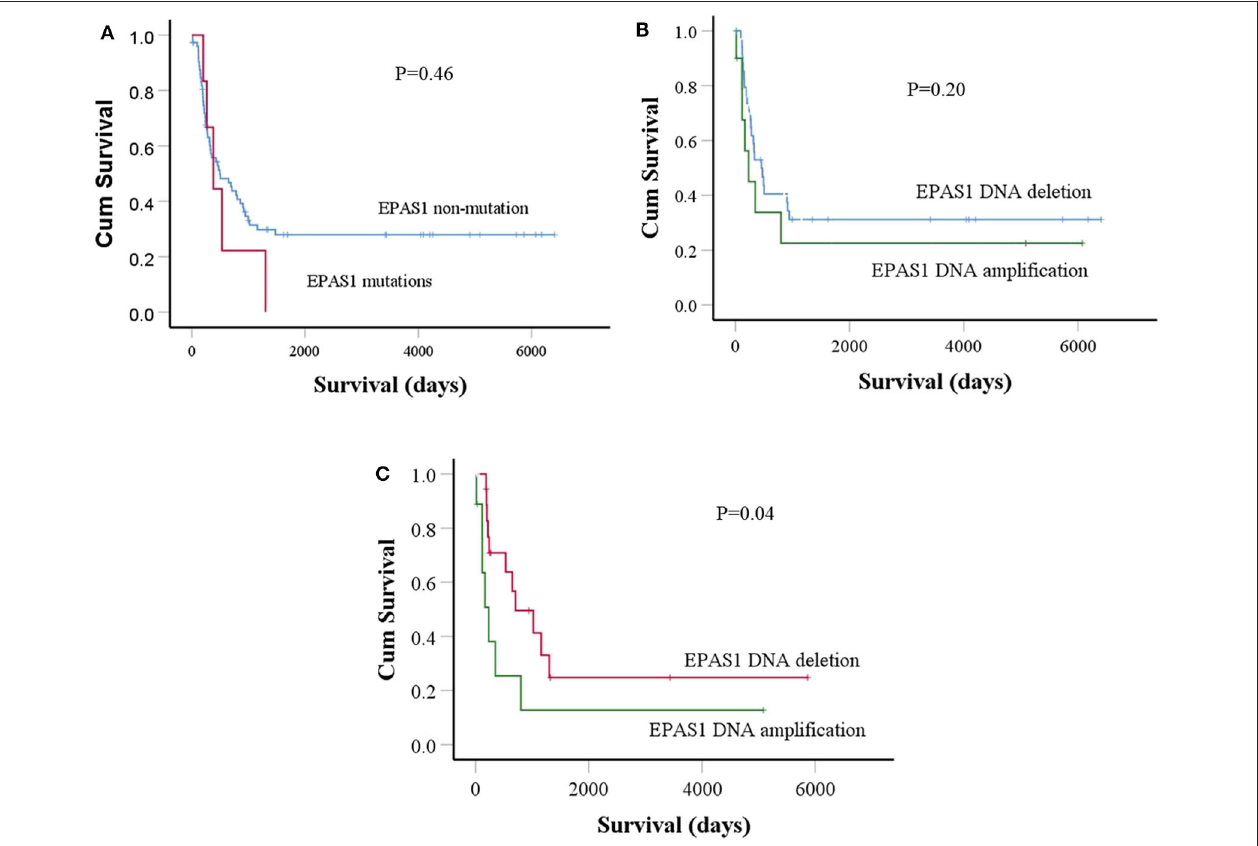
FIGURE 4 | Prognostic significance of EPAS1 dysregulation in ESCC. (A) The trends of EPAS1 -mutated positive patients had shorter survival rates compared to the nonmutated patients. However, the difference did not reach statistical significance level ( p = 0.46). (B) Patients with EPAS1 DNA amplification had poorer survival than EPAS1 DNA deletion ( p = 0.20). (C) In stage III patients with ESCC, the survival rates of patients having EPAS1 DNA amplification is significantly poor when compared to that of EPAS1 DNA deletion ( p =